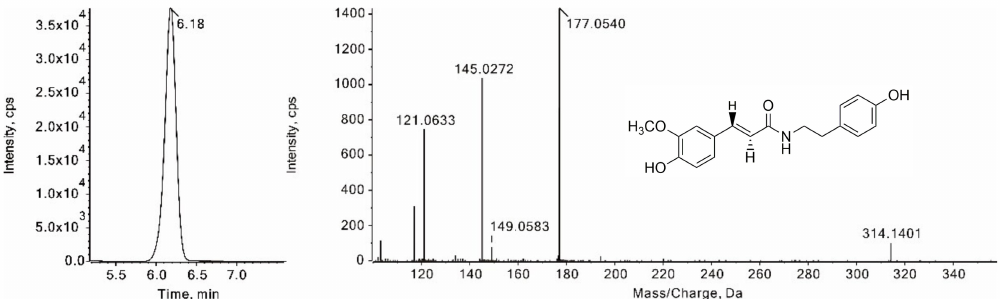
Figure 9. XIC and the MS/MS spectrum of trans- N -feruloyltyramine. Finally, a total of 42 alkaloids were tentatively annotated from the ethyl lactate ex- tracts of lotus seed epicarp. Except nuciferine, isoliensinie and neferine, the remaining 39 alkaloids were tentatively annotated in lotus seed epicarp for the first